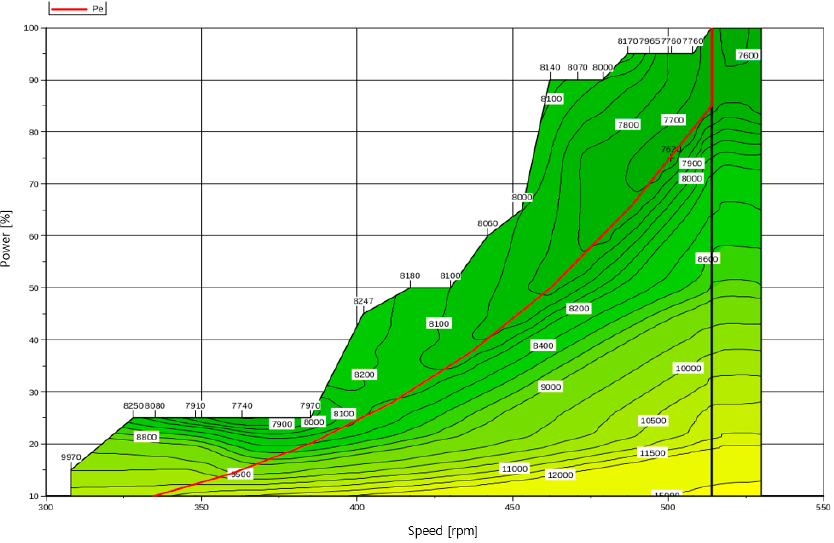
Figure 2. Comparison of fuel consumption according to engine speed change .